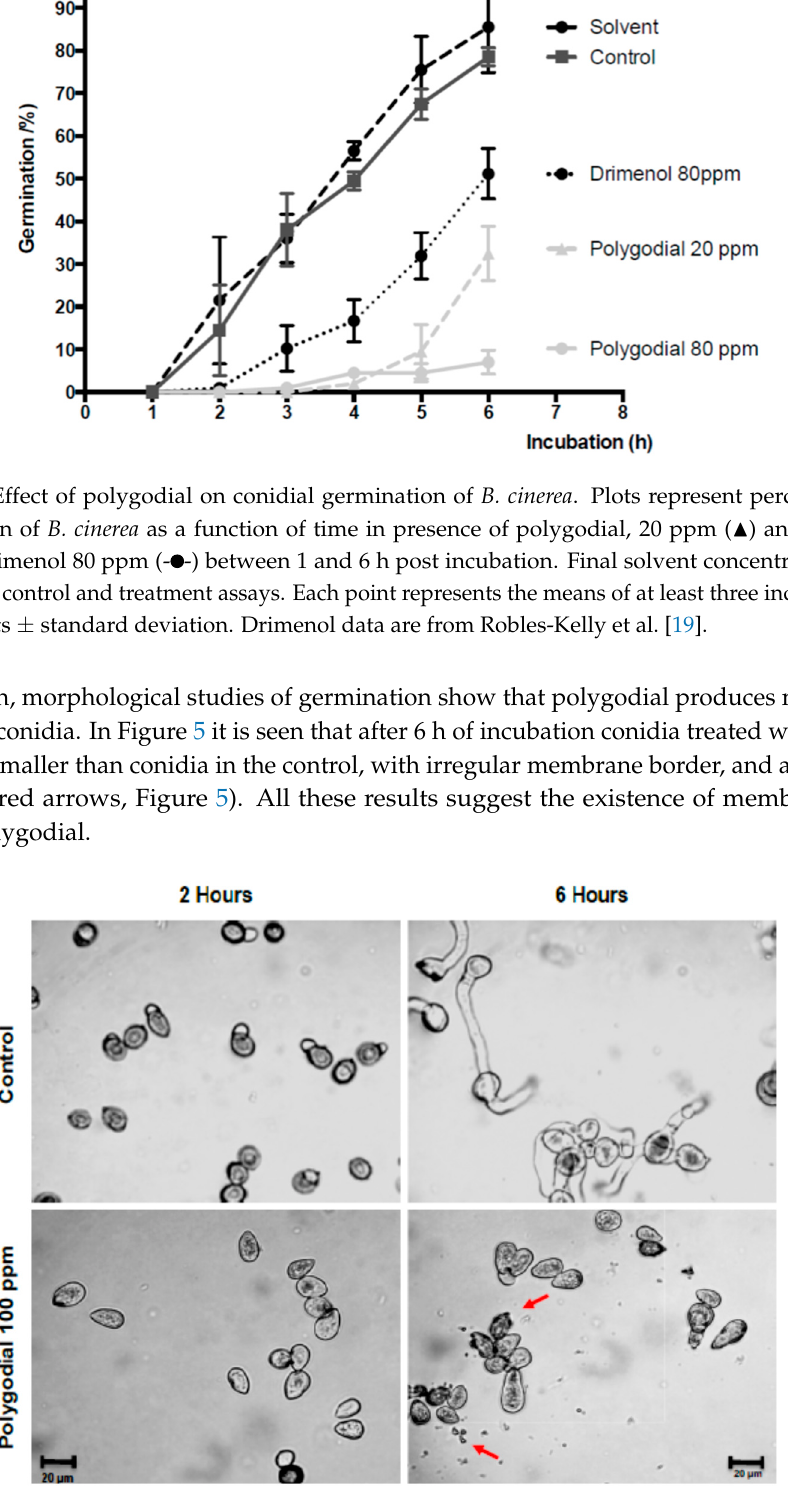
Figure 5. Morphological effect of polygodial on conidial germination of B. cinerea . Microphotographs correspond to B. cinerea germination in presence of 100 ppm of polygodial at 2 and 6 h post incubation. Final solvent concentration was identical in the control and treatment assays. Each bar corresponds to 20 µm. The red arrows indicate cell debris.